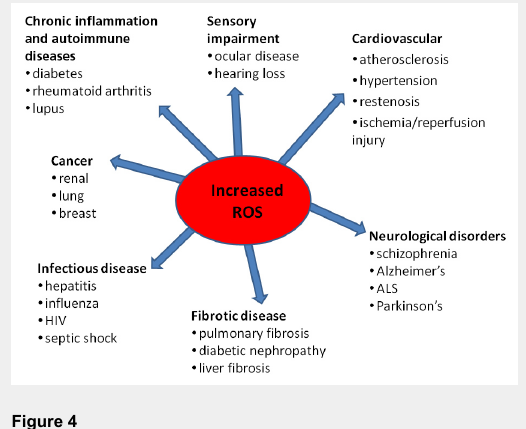
Overproduction of ROS and its contribution to various disease